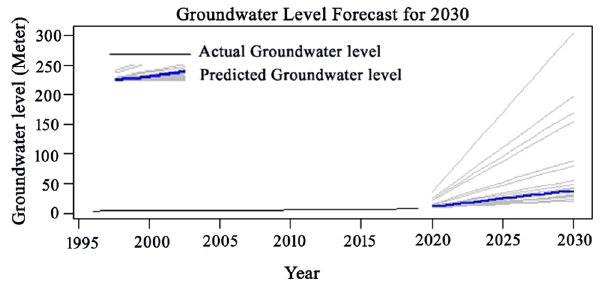
Fig. 25 Predicted groundwater level for 2030 for entire